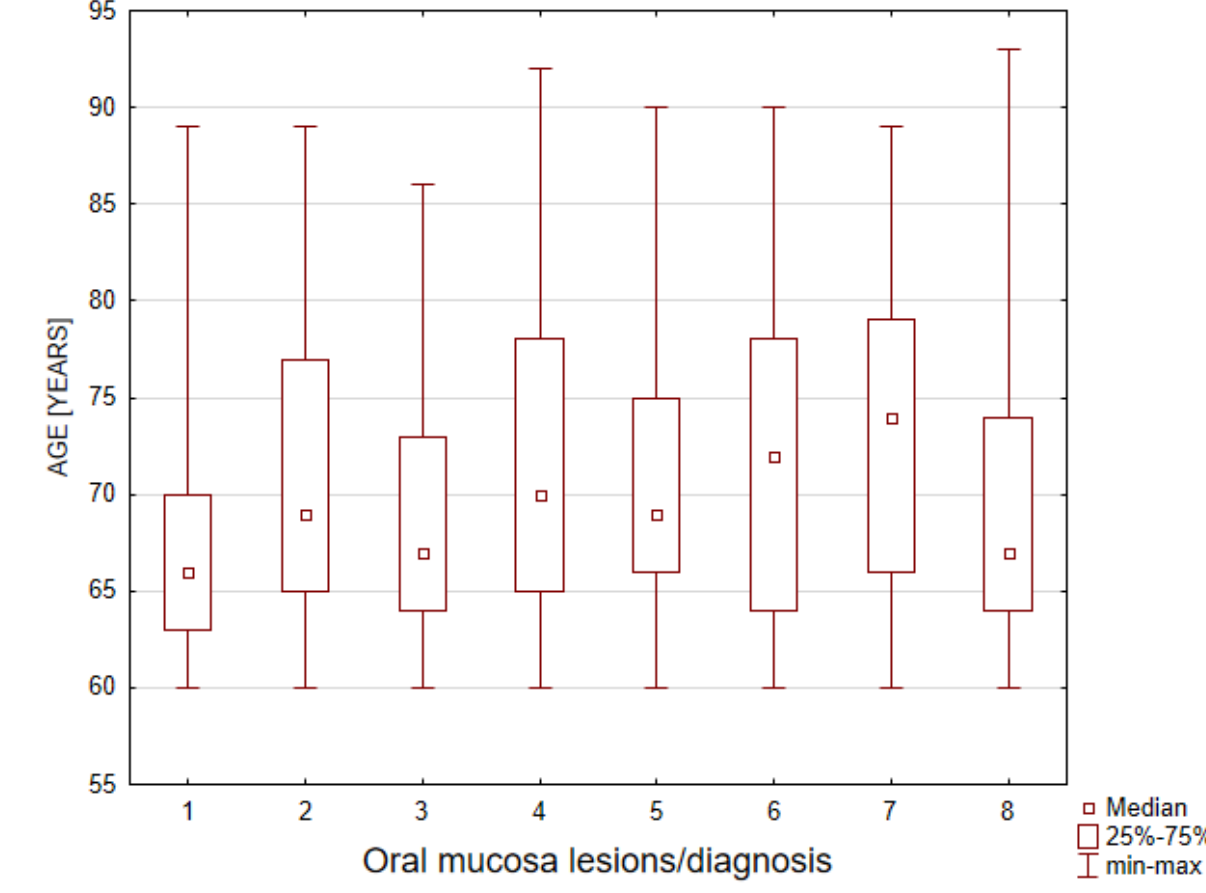
Figure 1. The age distribution of the patients in each oral mucosa diagnosis using the Kruskal- Wallis signed rank test, p = 0.000. The numbers found in the diagnosis axis refer to the diagnosis numbers from Table 3.